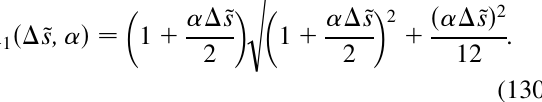
FIG. 2. (Color) I (cid:3) x; (cid:15) (cid:5) vs x for various (cid:15) given by Eq.